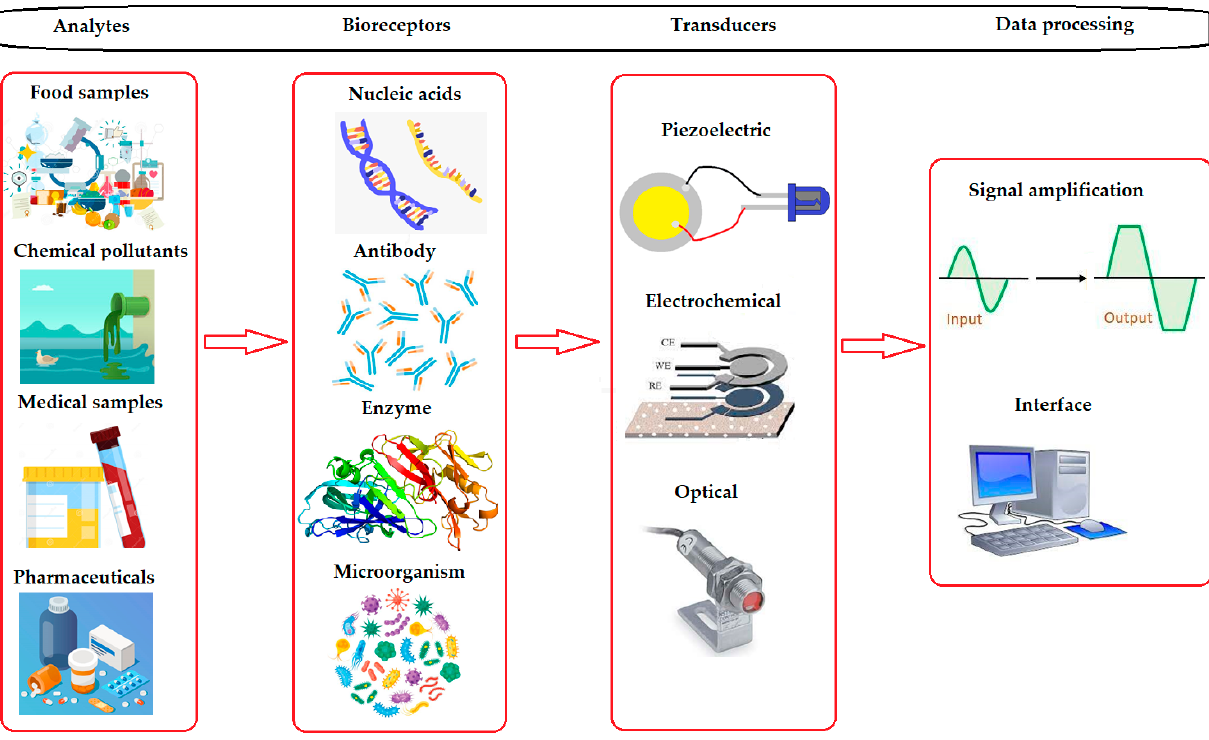
Figure 1. Components of a typical biosensor.